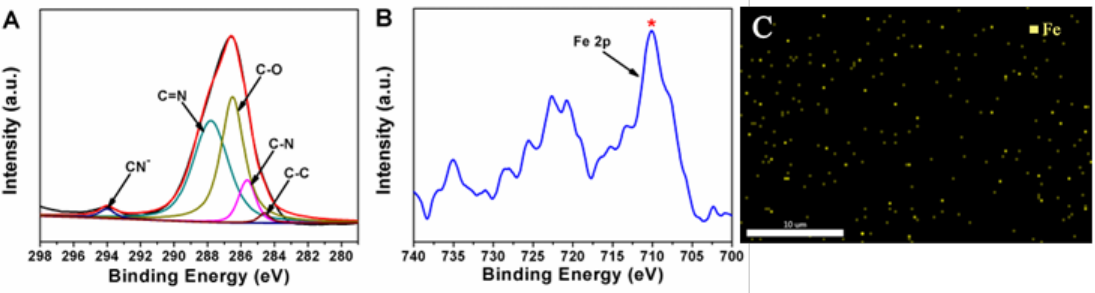
Figure 2. ( A ) The XPS spectra of C 1 s and ( B ) Fe 2p core level of MCF-IL-Fe(CN) 63 − ; ( C ) SEM-EDS element-mapping image of Fe in MCF-IL-Fe(CN) 63 − .